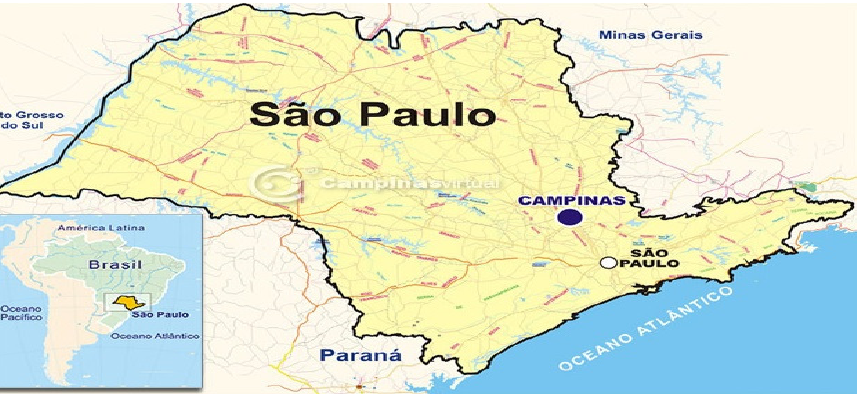
Figure 3. Location of the city of Campinas, São Paulo, Brazil.